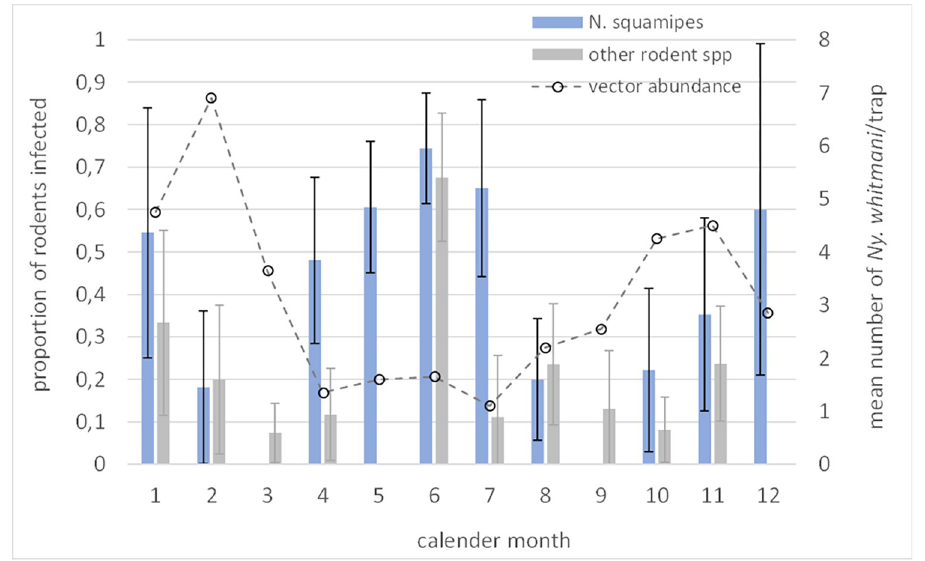
Fig 3. Proportion of rodent populations infection by calendar month. Prevalence calculated for N . squamipes , and other rodent species by aggregating data. Superimposed is the mean number of Ny . whitmani sand flies per month collected by CDC light trap in this and nearby foci (published data from Brand ã o-Filho et al 1994 [19]).